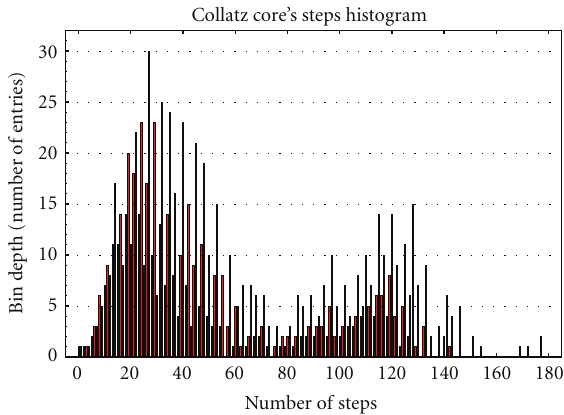
Figure 14: Collatz core’s histogram of